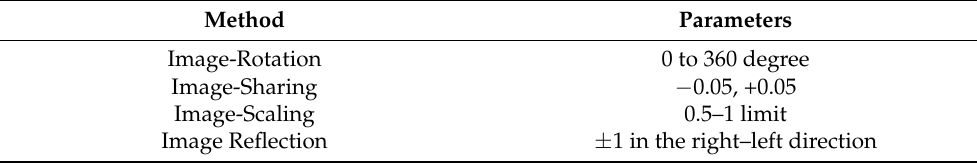
Table 1. Augmentation